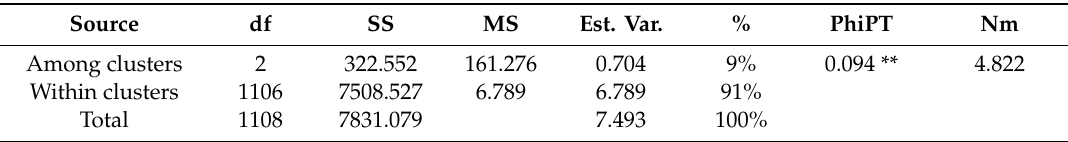
Table 3. Analysis of molecular variance (AMOVA) within / among ginseng clusters based on 17 SSR data according to conservation institutes.